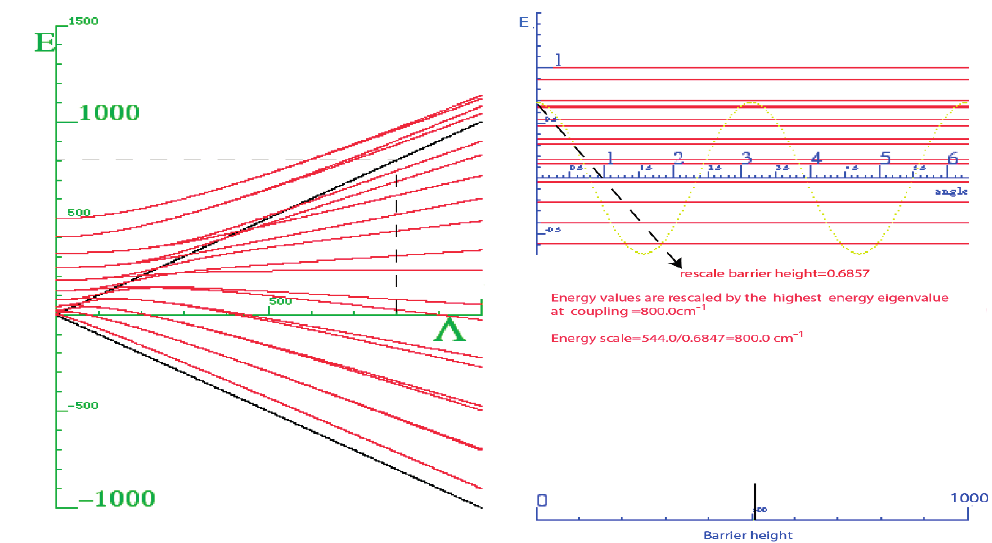
Figure 8. Left : Energy vs. coupling constant for Equation (21) with (cid:1836) = (cid:1828) = 2.5 (cid:1855)(cid:1865) (cid:2879)(cid:2869) ; Right : Displaying the potential energy curve and energy levels at (cid:1828) ℓ (cid:3019) single coupling constant Λ = 800 cm − 1 and barrier height = 540 cm − 1